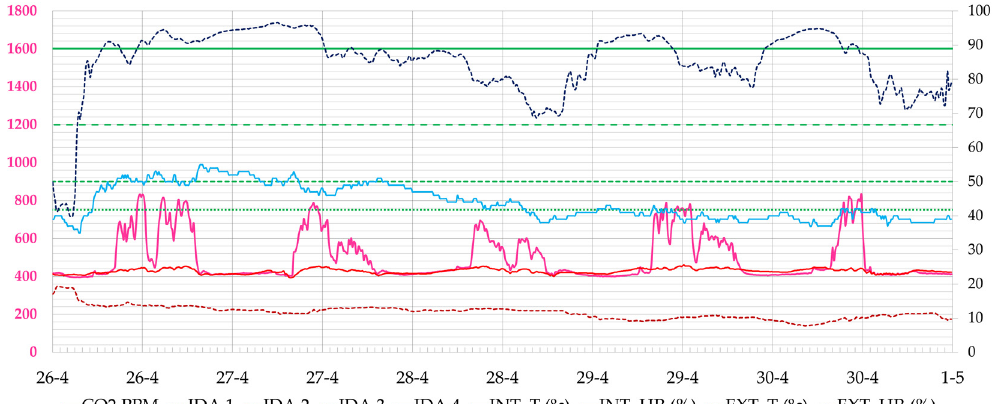
Figure 20. Evolution of CO 2 concentration, interior and exterior temperature and relative humidity in classroom A 2.1 during the week of 26 April 2021 to 2 May 2021 (Phase II). Source: authors.